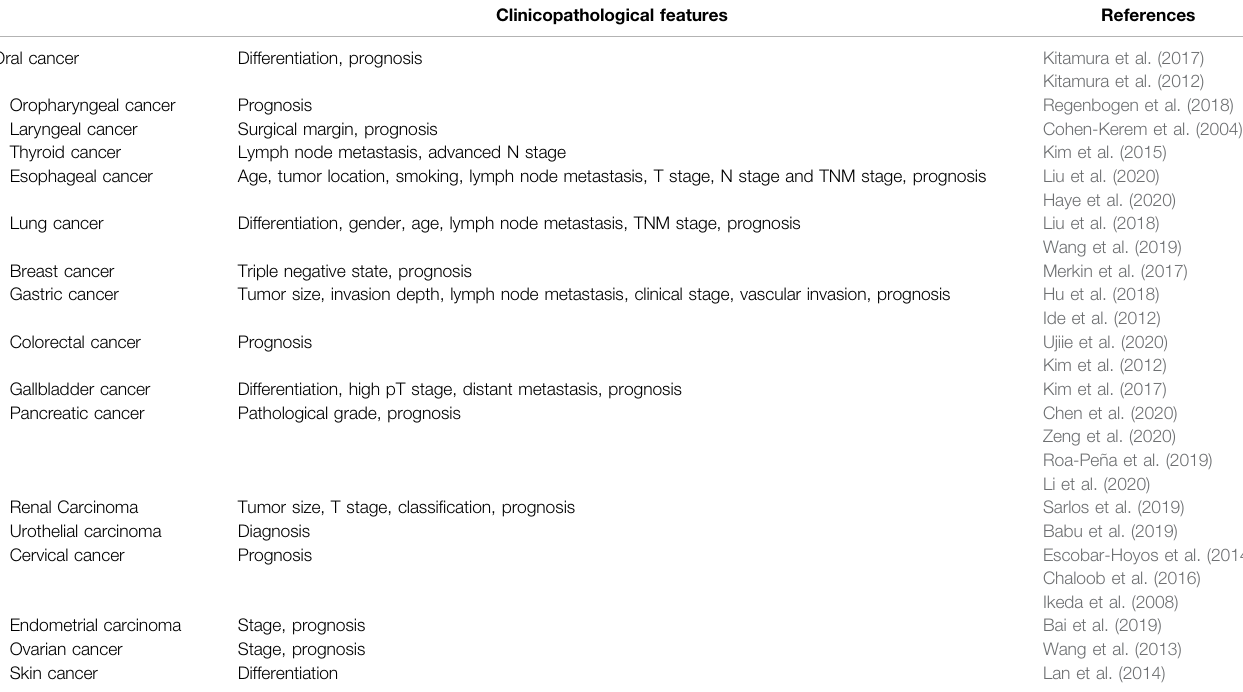
TABLE 1 | Clinical signi fi cance of Keratin17 in various types of